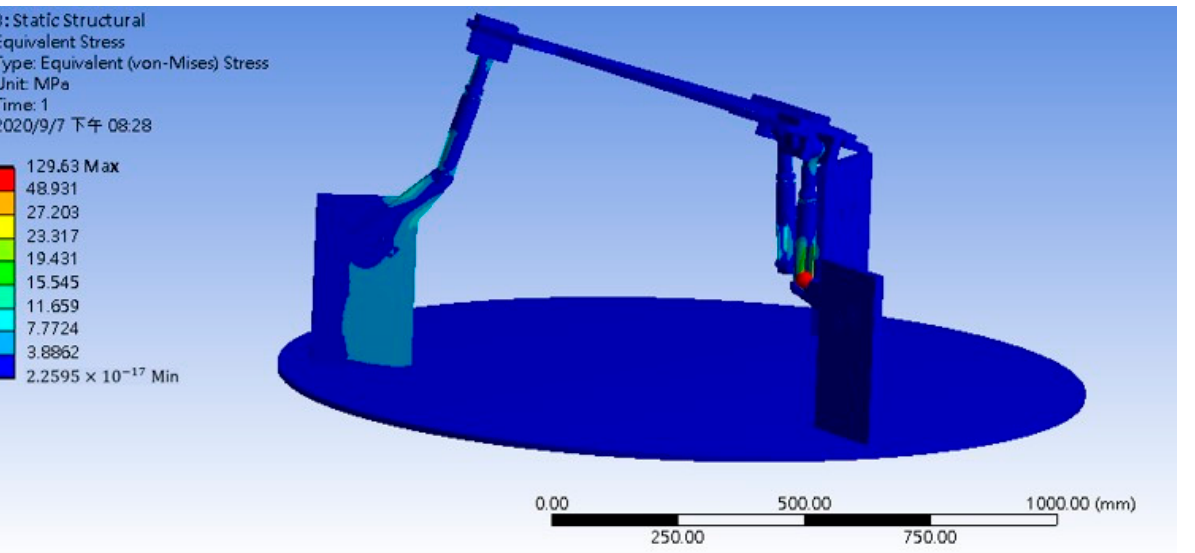
Figure 14. The stress trend chart of the roll motion. For the pitch motion, the platform motion angles were 0°, 10°, and 20°. The simula- tion results showed that the maximum stress was located at the angle of 20° with a maxi- mum stress of 119.79 MPa. The maximum stress analysis result is shown in Figure 15. The pitch motion stress trend is shown in Figure 16. 0.0